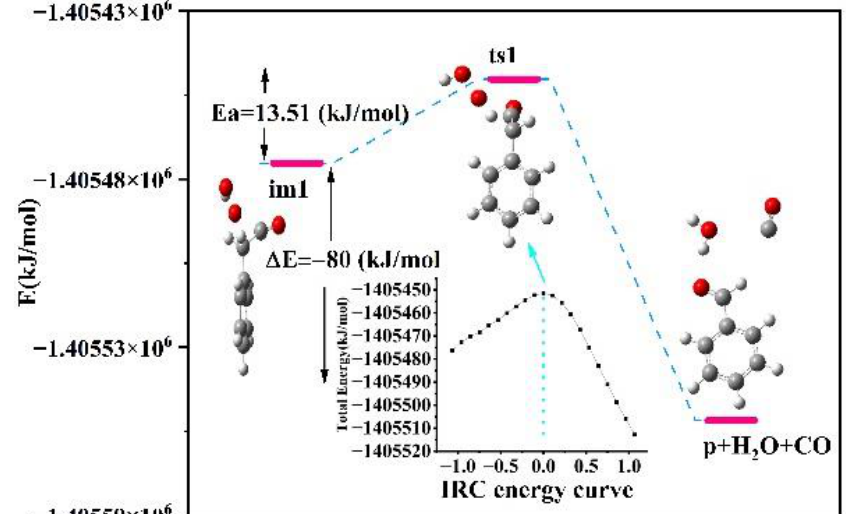
Figure 7. Activation energy of CO generated by aldehyde group.